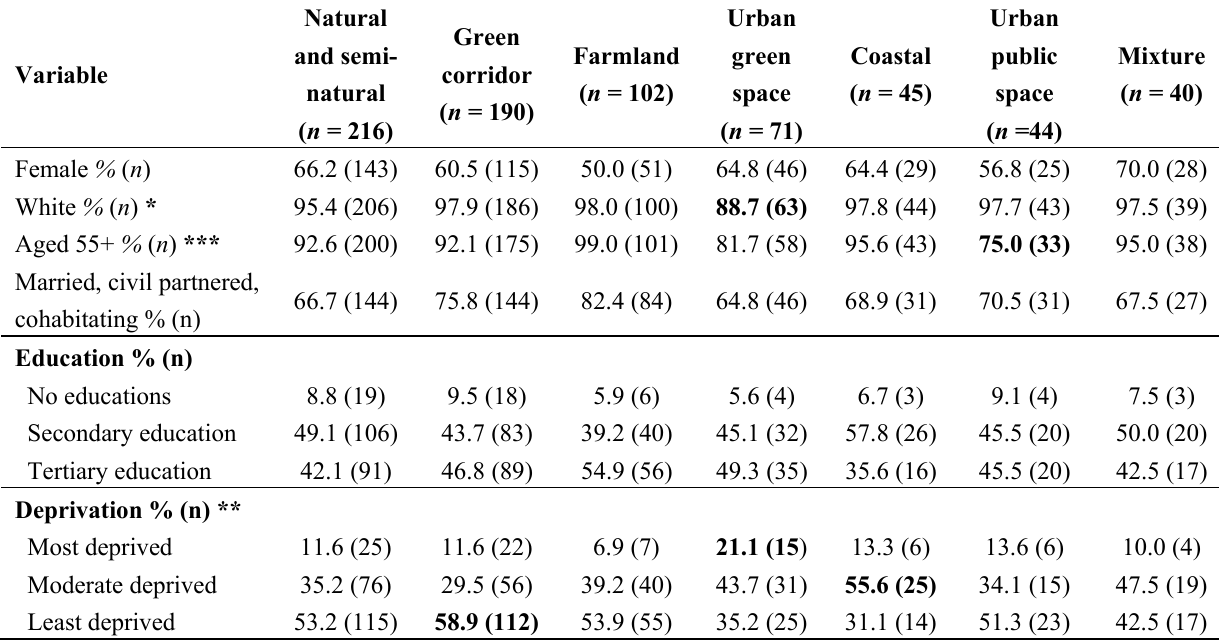
Table 2. Socio-demographic characteristics of frequently attending group walkers as a function of the main type of environment in which they walked with the group in the past 13 weeks ( n =